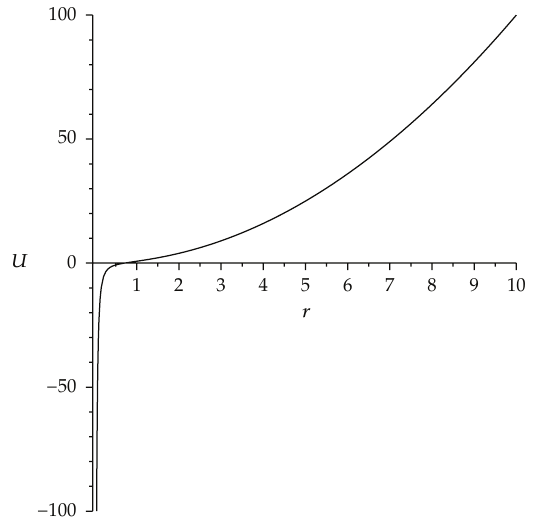
Figure 2: Graph of the effective potential 𝑈(𝑟) = 𝑟 2 − 1/4𝑟 2